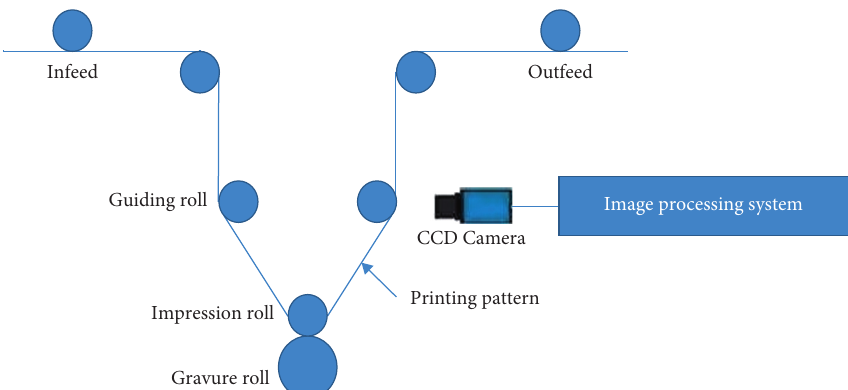
Figure 2: The diagram of defect detection system using machine vision for gravure printing